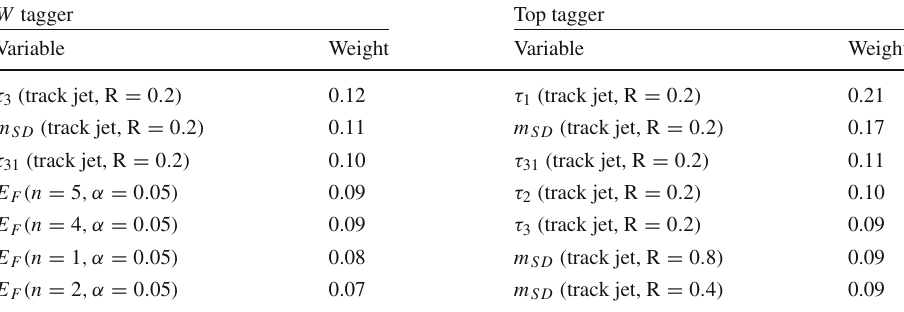
W tagger Top tagger